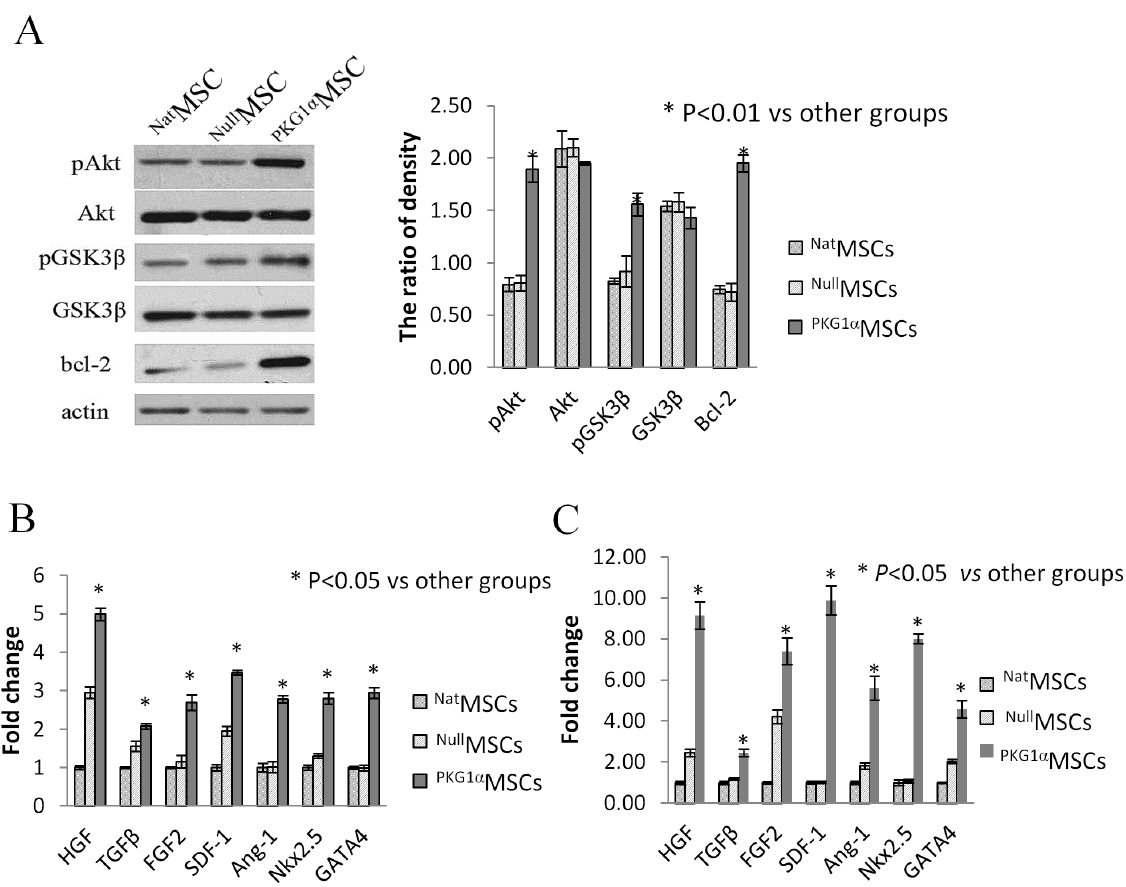
Figure 3. PKG1 a overexpression activated pro-survival pathway in vitro. (A) Increased phosphorylation of Akt,GSK3aˆ and high level of Bcl-2 expression were detected in PKG1a´ MSCs by western blot after 48 h OGD, protein expression of pAkt, pGSK3aˆ and Bcl-2 are 2.4, 1.7, 2.8 fold higher respectively as compared to Nat MSCs without changing the total level of Akt and GSK3aˆ ( p , 0.01). (B and C) Real-time PCR based gene array analysis showed several pro-survival and angiogenic factors including HGF, TGFaˆ, FGF2, SDF-1 and Ang-1 as well as 2 cardiac transcription factors Nkx2.5 and GATA4 genes significantly increased as compared with the control cells (n=3 experiments) before or after OGD ( p , 0.05). doi:10.1371/journal.pone.0060087.g003 survival rate (Fig. 5A) based on the sry-gene analysis, and had fewer TUNEL + cells amongst transplanted MSCs (Fig. 5B) and cardiomyocytes in or around infarct regions (Fig. 5C). Higher caspase-3/7 activity was detected in DMEM and Null MSCs group compared to PKG1 a MSCs group (Fig. 5E). Expression of anti- apoptosis proteins including pAkt, pGSK3 b and Bcl-2 (Fig. 5D), and pro-survival and angiogenic factors including HGF, bFGF, SDF-1 and Ang-1 (p , 0.01) (Fig. 5F) were significantly increased. PKG1 a MSCs promoted myoangiogenensis in the infarcted rat hearts. At day 3 after transplantation, upregulation of